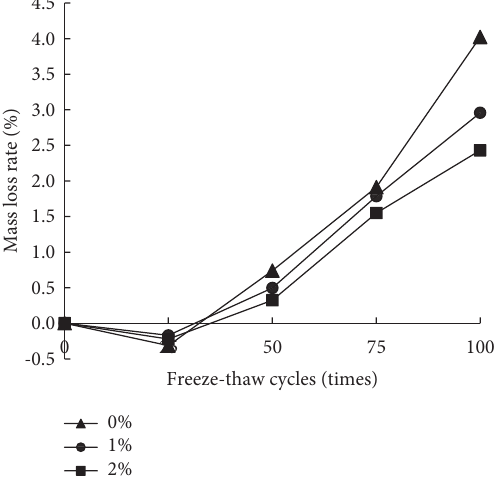
Figure 9: Mass loss rate curve of the freeze-thaw